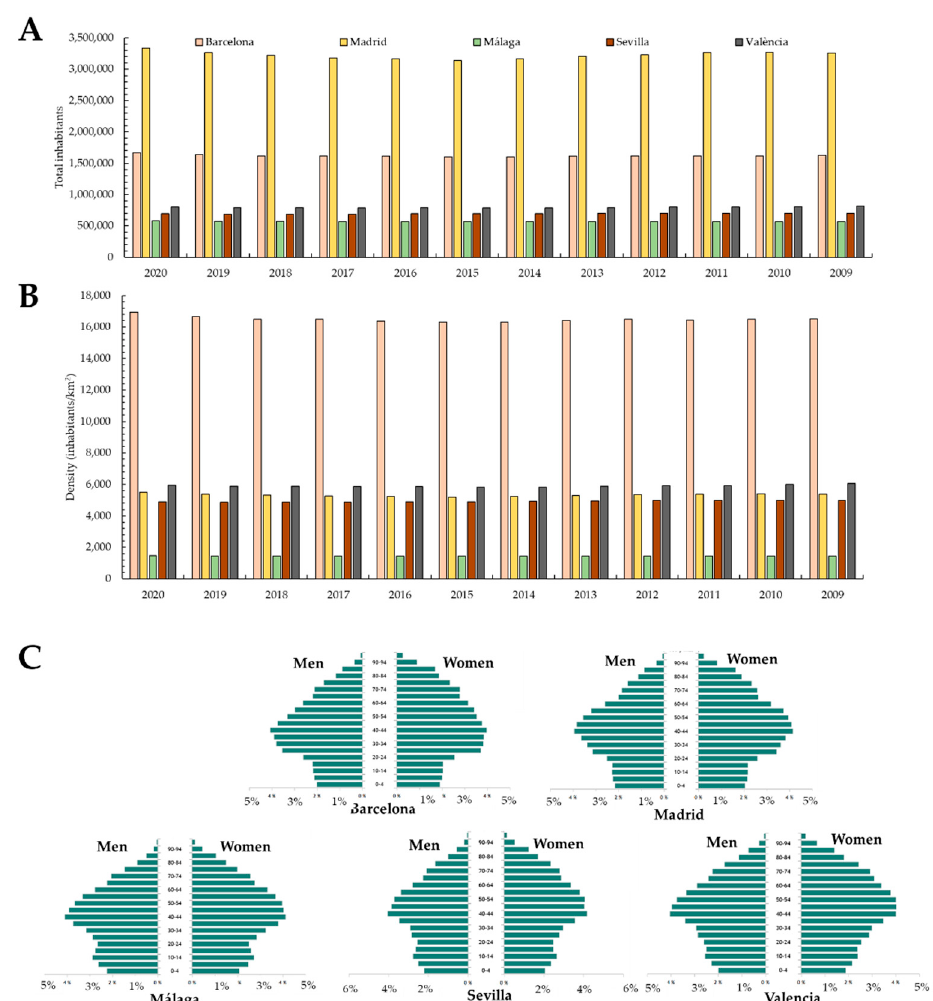
Figure 2. Demographical characterization of the five most highly populated cities in Spain. ( A ) Total population. ( B ) Density. ( C ) Population pyramid. Source: Instituto Nacional de Estadística (INE; Spanish National Statistics Institute).